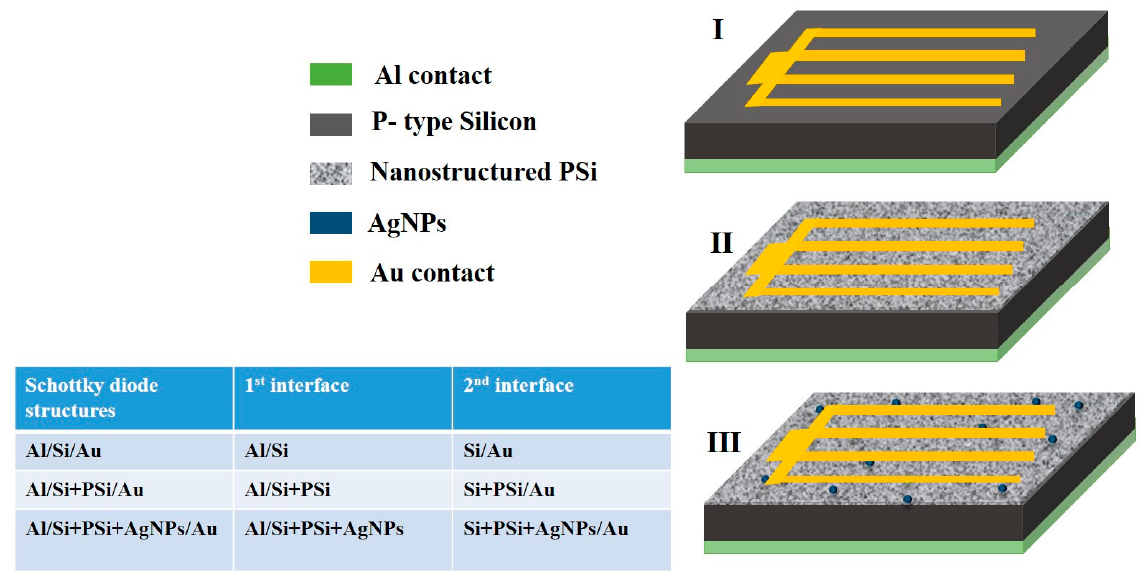
Figure 1. Schematic view of the structure of the fabricated diodes and a representation of the electrical interfaces between each layer: (I) Al/Si/Au diodes, (II) Al/Si + PSi/Au diodes, and (III) Al/Si + PSi + AgNPs/Au diodes.